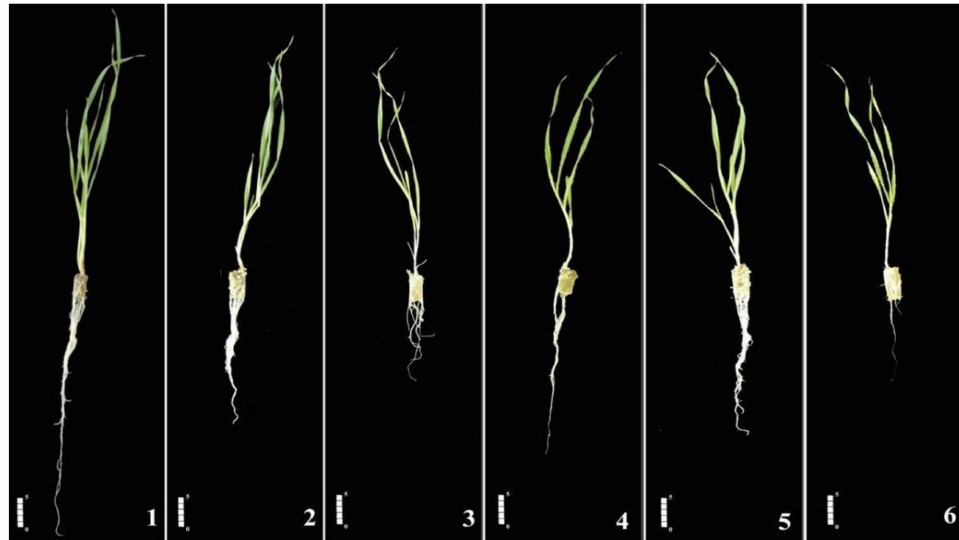
Figure 1. Effect of salicylic acid (SA) pre-treatment on growth of Hordeum vulgare L. ‘Ince-04 (cid:48) plants under control and saline conditions (150 and 300 mM NaCl): ( 1 ) Control; ( 2 ) 150 mM NaCl; ( 3 ) 300 mM NaCl; ( 4 ) 0.5 mM SA pre-treatment without NaCl stress; ( 5 ) 0.5 mM SA pre-treatment with 150 mM NaCl; ( 6 ) 0.5 mM SA pre-treatment with 300 mM NaCl. For SA pre-treatment, plants were irrigated with 0.5 mM SA for 24 h in a hydroponic system. Scale bar, 5